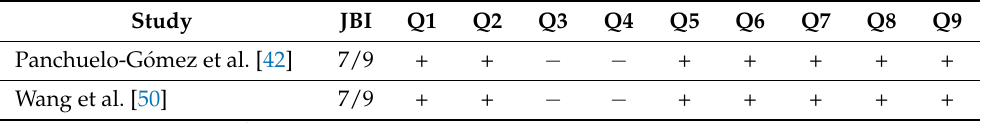
Table 4. The results of the quality assessment of quasi-experimental studies. Study